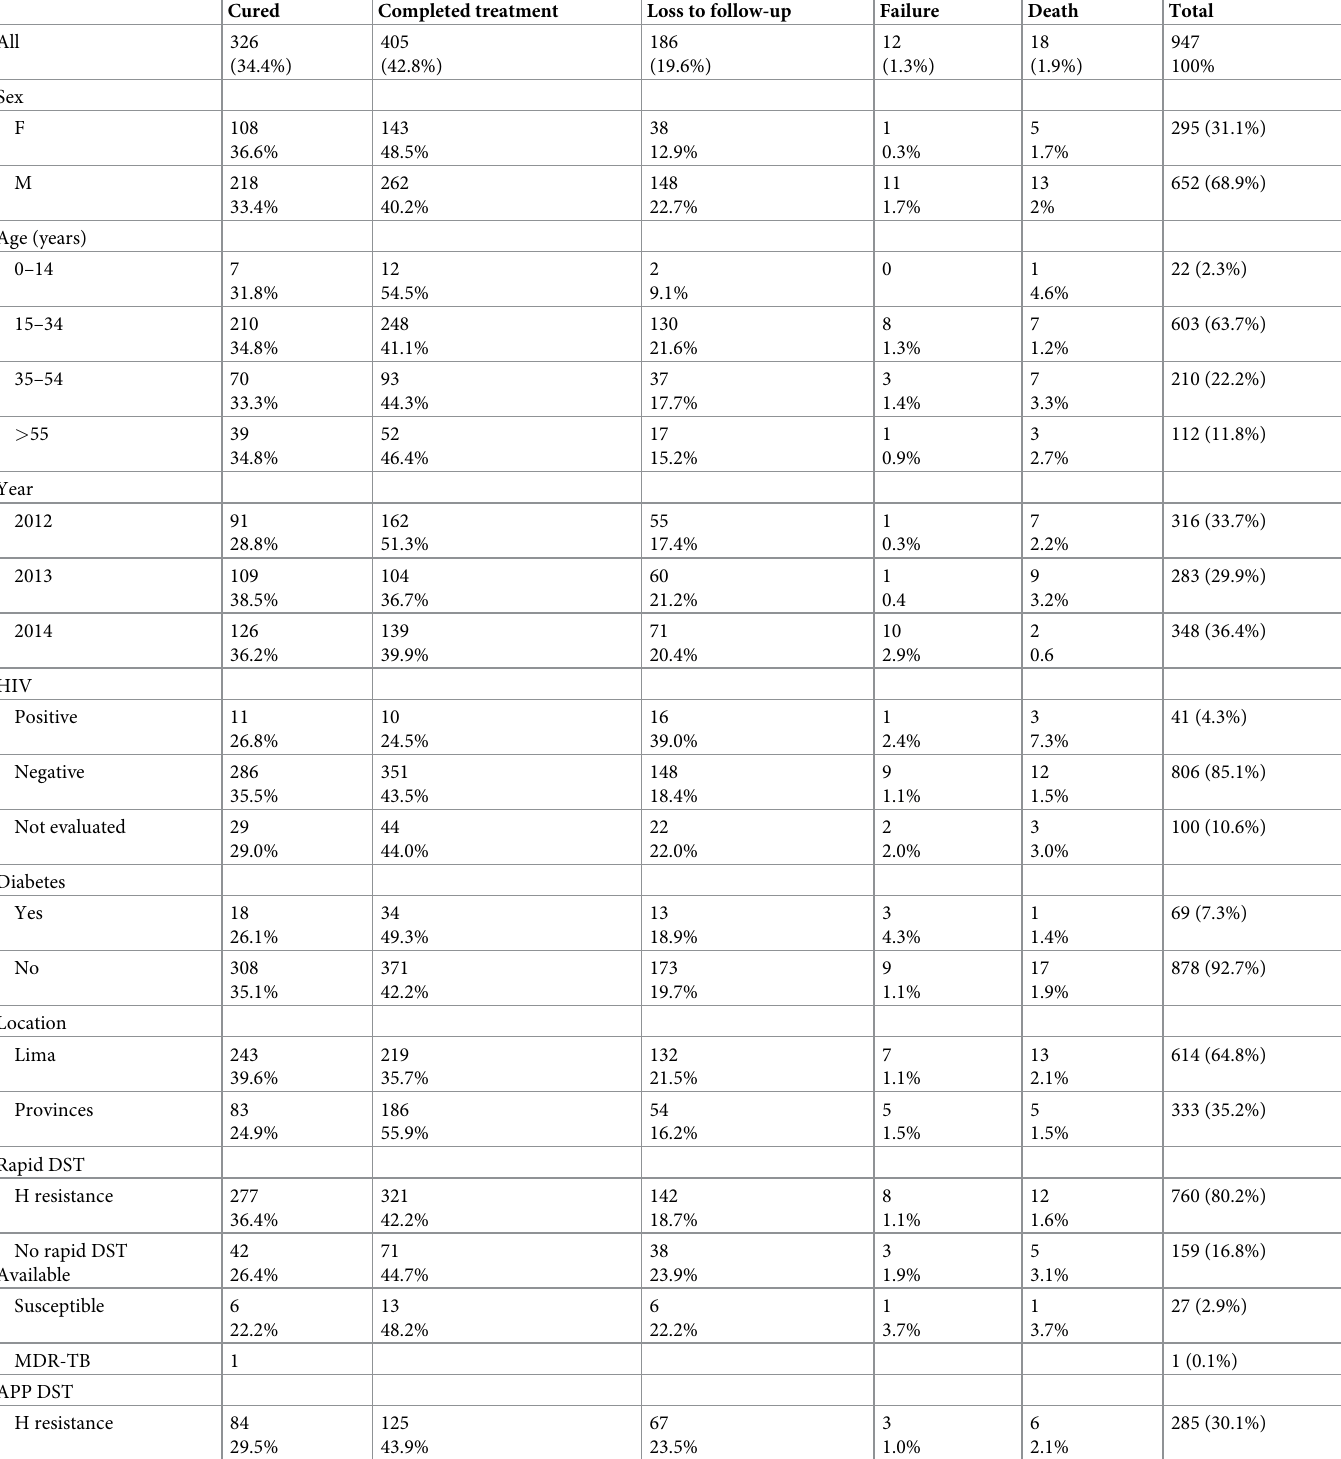
Table 2. Characteristics of evaluated cases (n = 947) based on treatment